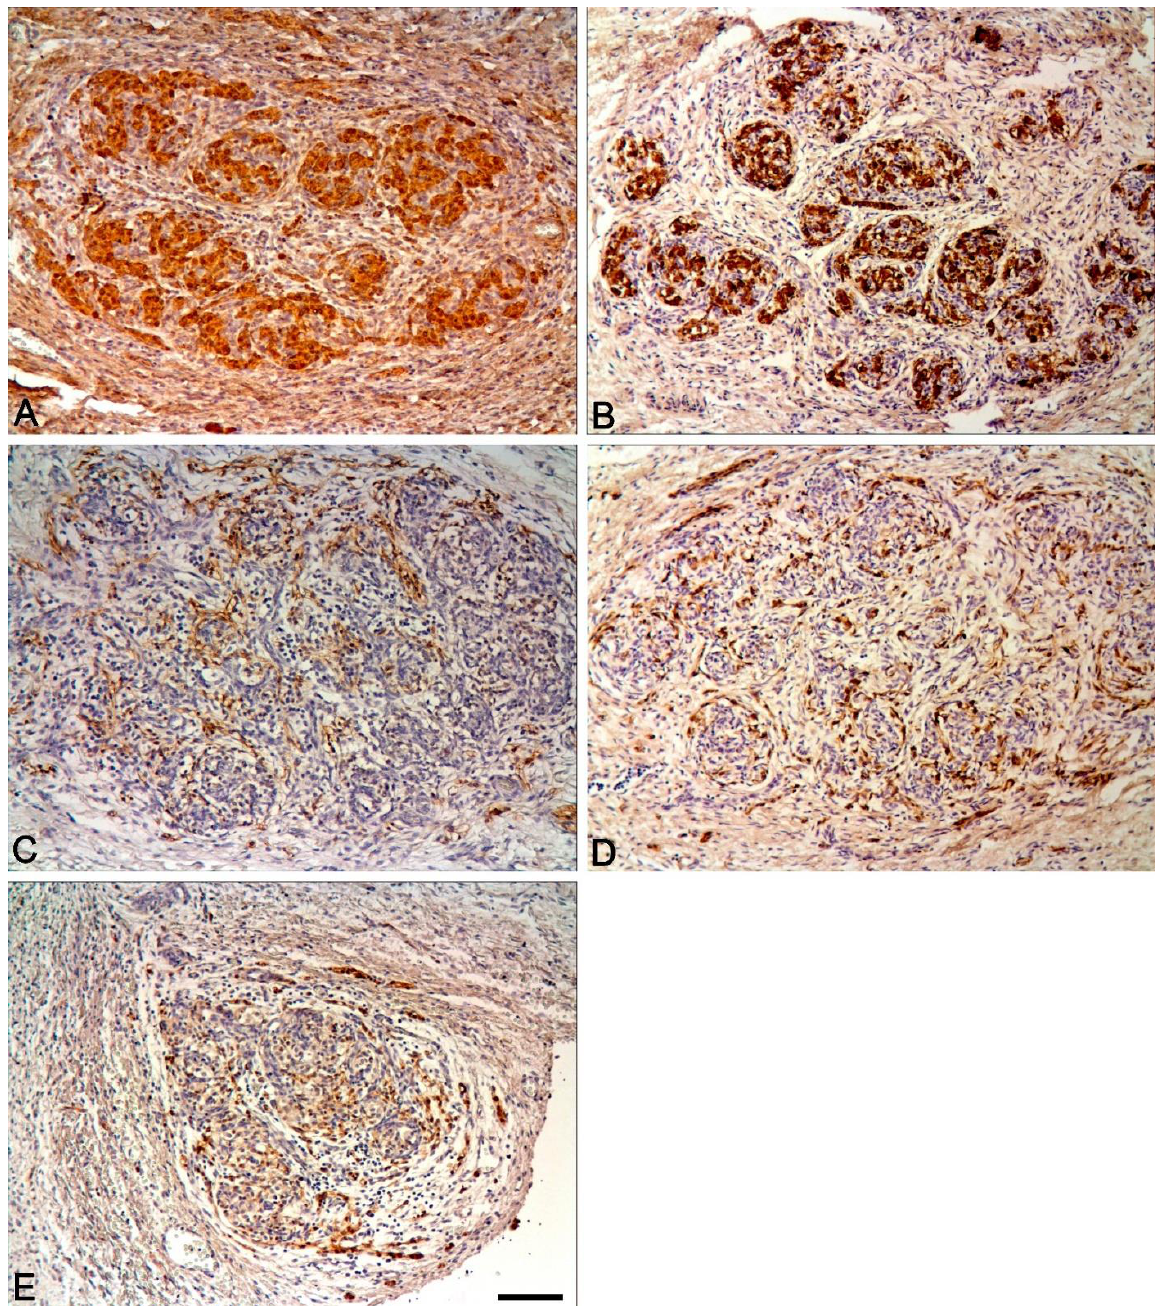
Figure 3. The human carotid body in the antenatal period. Expression of PGP9.5 ( A ), synaptophysin ( B ), neurofilaments ( C ), GFAP ( D ) and S100 ( E ). Nuclei stained with hematoxylin. Bar = 100 μm.